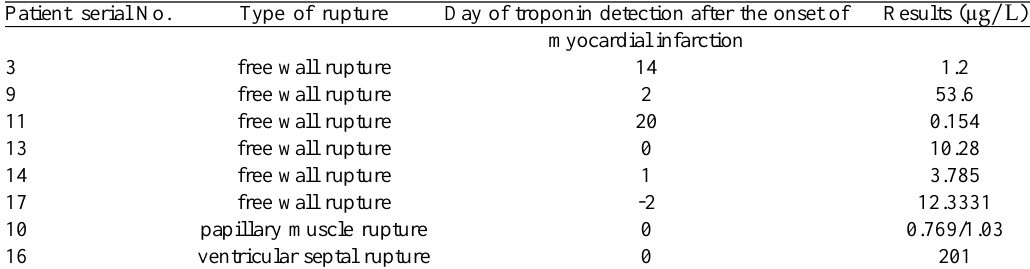
Table 2. Troponin values of the patients with myocardial rupture. Patient serial No.